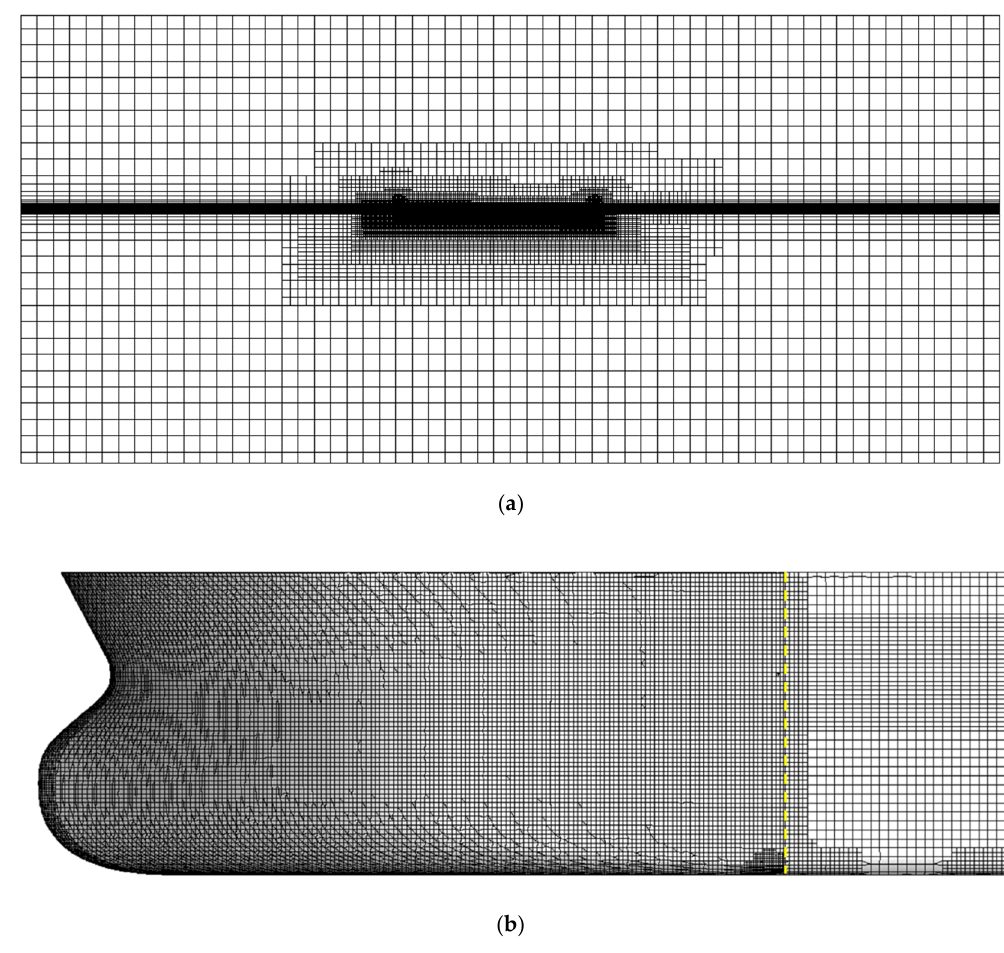
Figure 7. Grid shape for Japan bulk carrier (JBC) resistance calculation. ( a ) whole domain (side view), ( b ) surface mesh of fore body (side view).